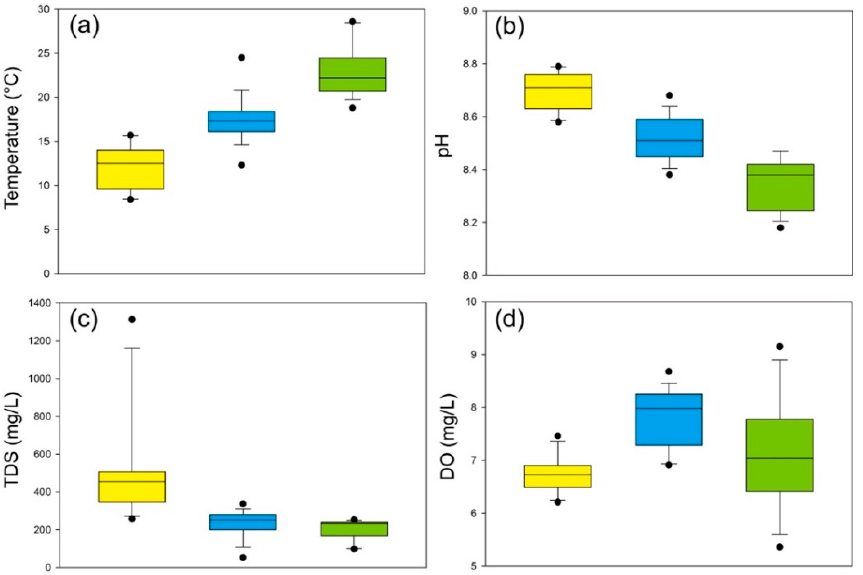
Figure 2. Boxplots of the chemical parameters of the Lancangjiang River: ( a ) temperature; ( b ) pH; ( c ) total dissolved solid (TDS); ( d ) dissolved oxygen